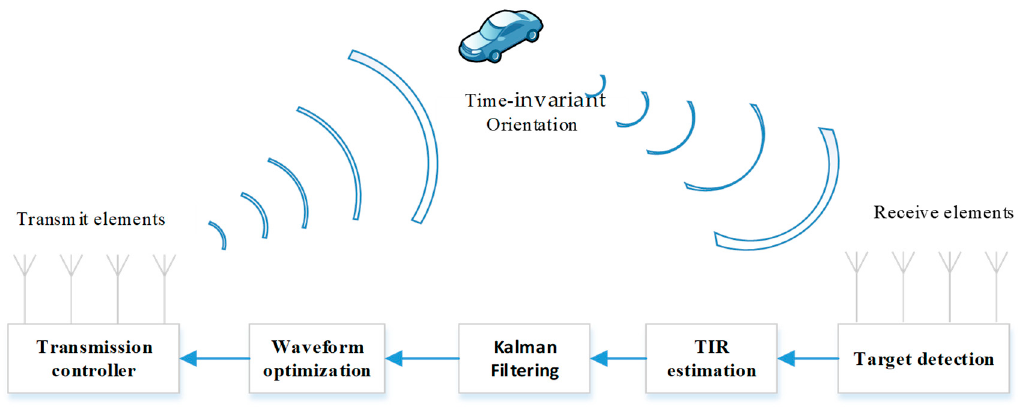
Figure 1. Adaptive multi-antenna radar architecture.